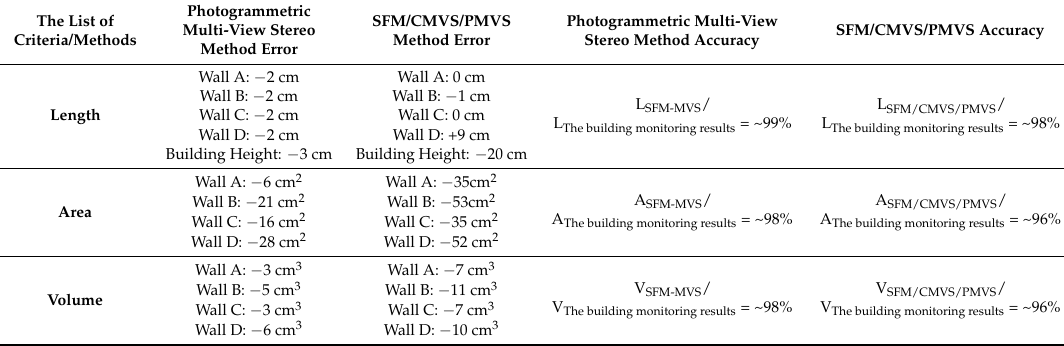
Table 4. Comparing the accuracy of as-built models generated by the proposed photogrammetric Multi-View Stereo method and SFM/CMVS/PMVS algorithm (case study 1).